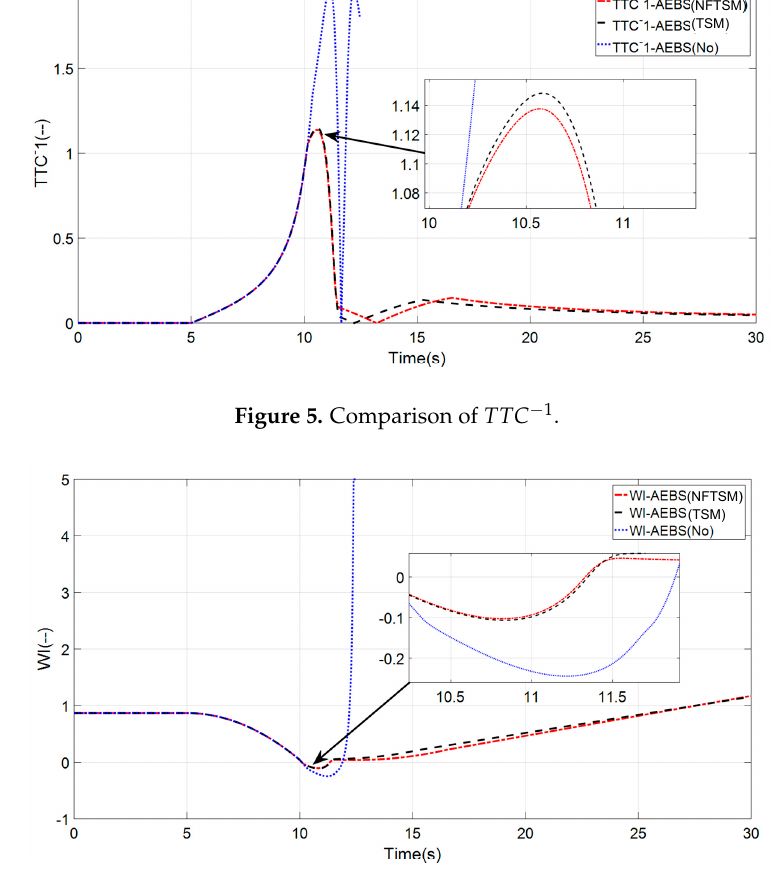
Figure 6. Comparison of WI .